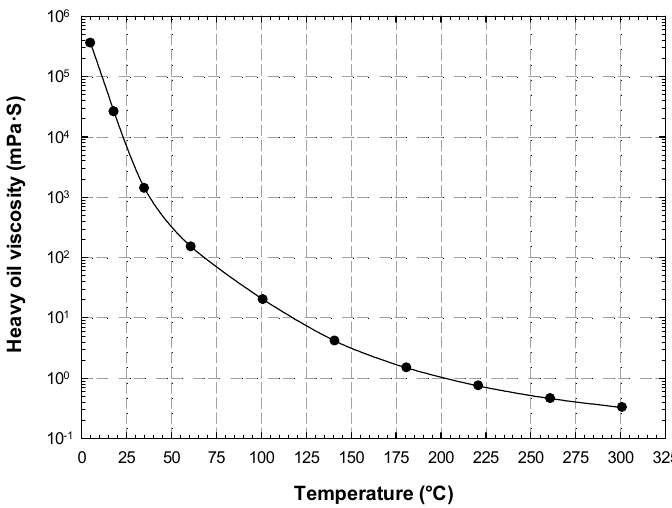
Figure 1. Heavy oil viscosity reduction with increasing temperature at the atmosphere pressure. Table 1. Properties of the reservoir in the Pikes Peak oil field, Lloydminster region.